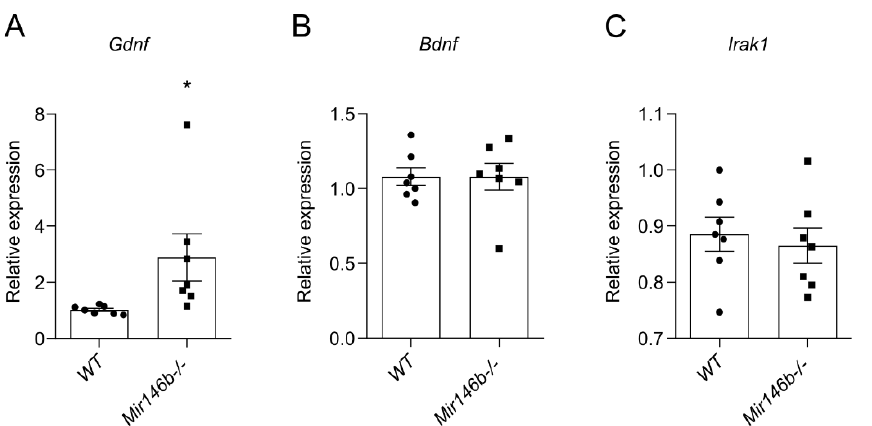
Figure 7. Gdnf mRNA is upregulated in Mir146b-/- mice. ( A ) Relative mRNA expression of miR- 146b targets Gdnf . ( B ) Bdnf and ( C ) Irak1 of WT and Mir146b-/- mice. Number of animals = 7, Stu- dent’s t -test. Data represented as mean ± SEM respectively; * p < 0.05.